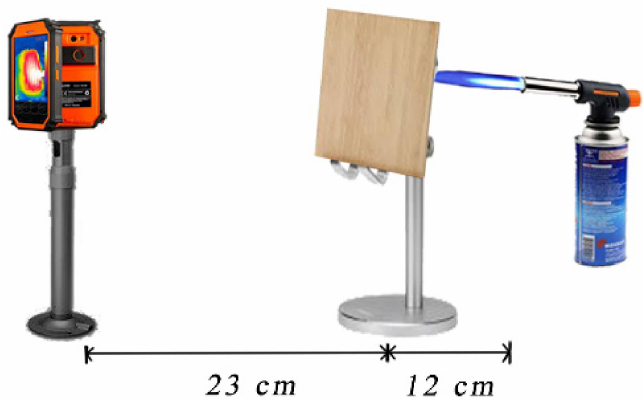
Figure 2. Ultrahigh-temperature stimulation measuring set-up using a butane blowlamp